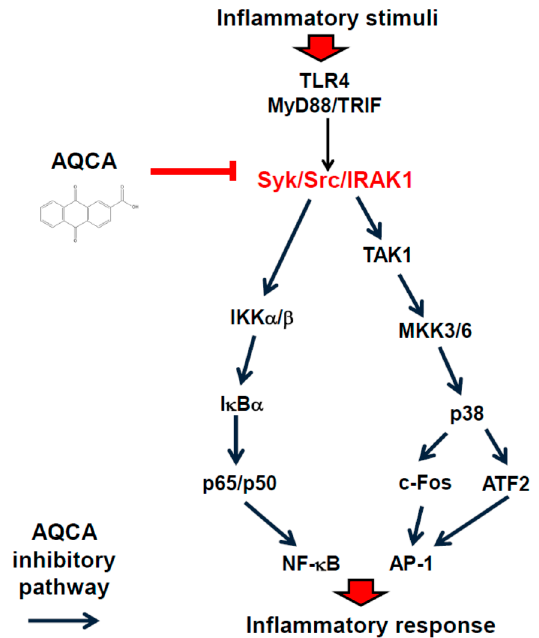
Figure 5. Putative pathway for the inhibition of inflammatory signaling events by AQCA in in vitro inflammatory responses.